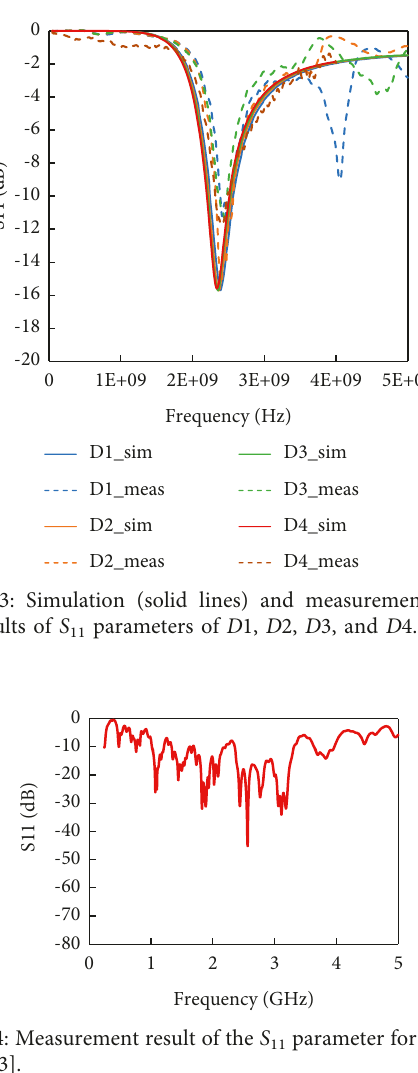
11 parameter for the whole